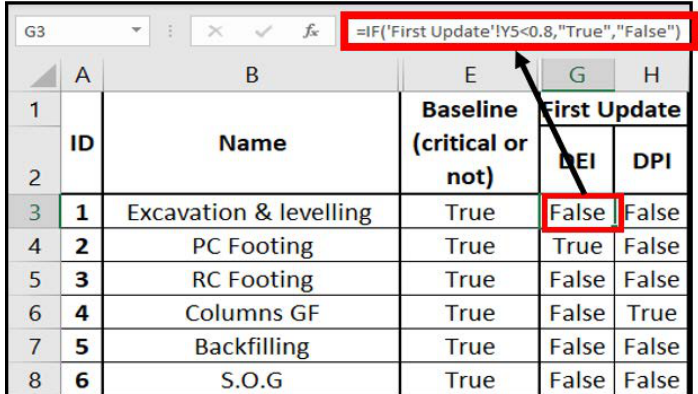
Figure 5. If function used for data